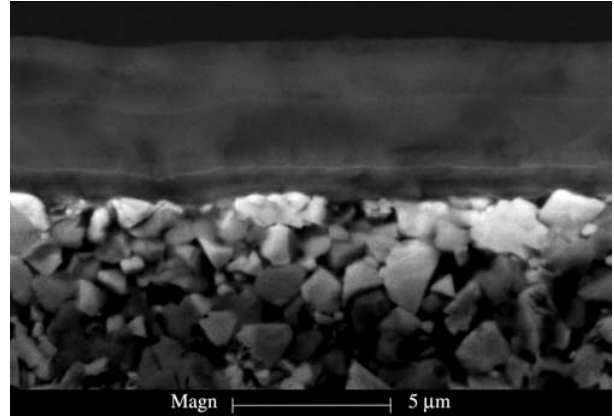
Figure 2. Fracture surface of the TiN/(Ti,Al,Si)N/TiN coating deposited on the W2 type cemented carbide surface.